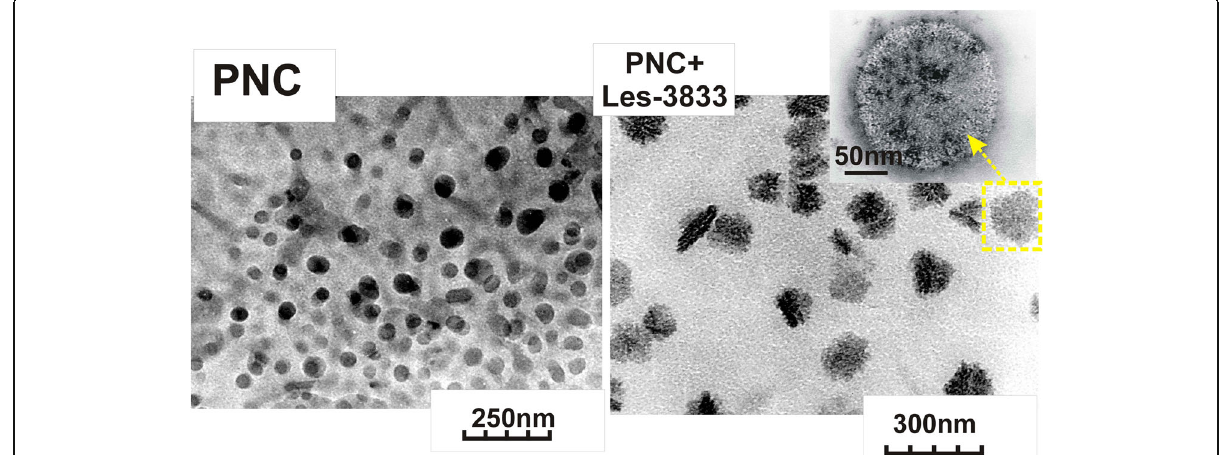
Fig. 3 Transmission electron microscopy (TEM) images of the PNC (left) and complex of PNC + Les-3833